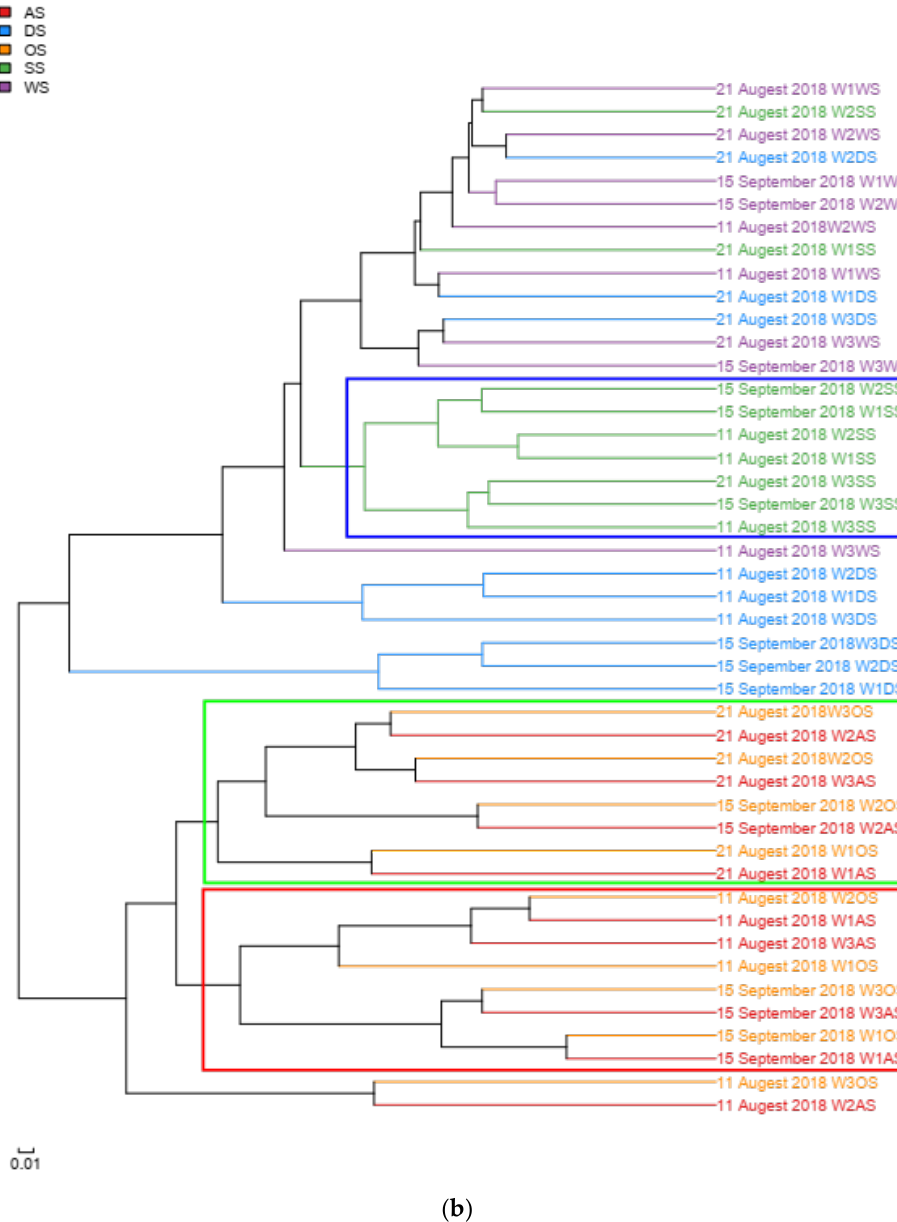
Figure 4. NMDS and Hcluster_tree based on weighted_unifrac_otu and bray_curtis, respectively, in Jinshitan bathing beach during typhoon events. ( a ) NMDS; ( b ) Hcluster_tree.